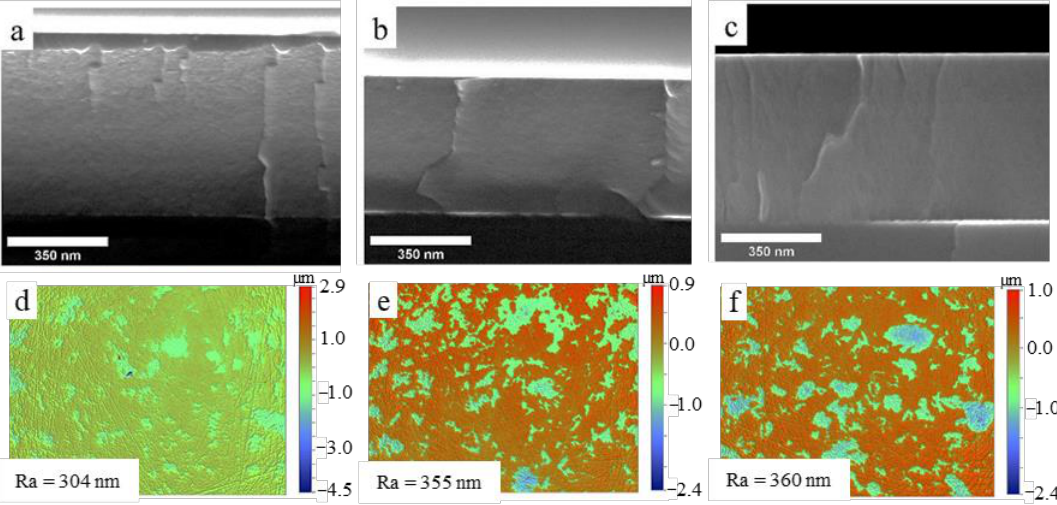
Figure 3. Cross-section SEM and surface images of the coatings 1 ( a , d ), 2 ( b , e ), and 3 ( c , f ).